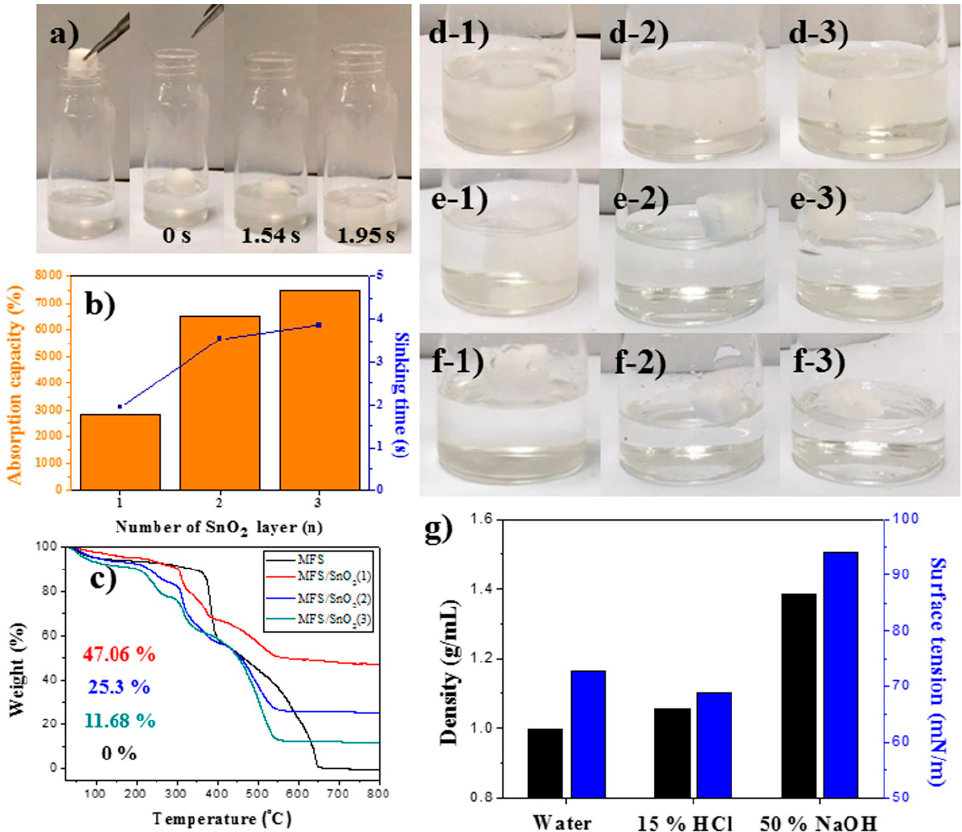
Figure 4. Drop tests of SnO 2 -coated MFS with a strong base solution. ( a ) MFS / SnO 2 (1). ( b ) Absorption capacity and sinking time of MFS / SnO 2 (1–3). ( c ) TGA data of MFS / SnO 2 (1–3). ( d – f ) Reusability test of MFS / SnO 2 (1–3). Drop tests of MFS / SnO 2 (1–3) for ( d ) 1st, ( e ) 2nd, and ( f ) 3rd use. ( d - 1 , e - 1 , f - 1 ) MF / SnO 2 (1), ( d - 2 , e - 2 , f - 2 ) MF / SnO 2 (2), and ( d - 3 , e - 3 , f - 3 ) MF / SnO 2 (3). ( g ) Density and surface tension of strong base solution (50% NaOH).